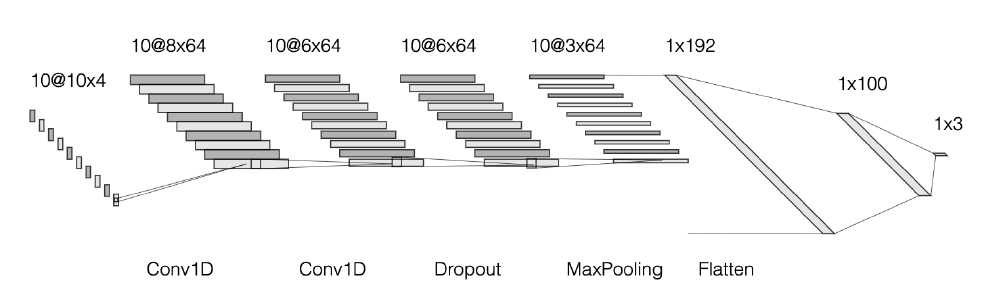
Figure 9. Layout diagram of a convolutional neural